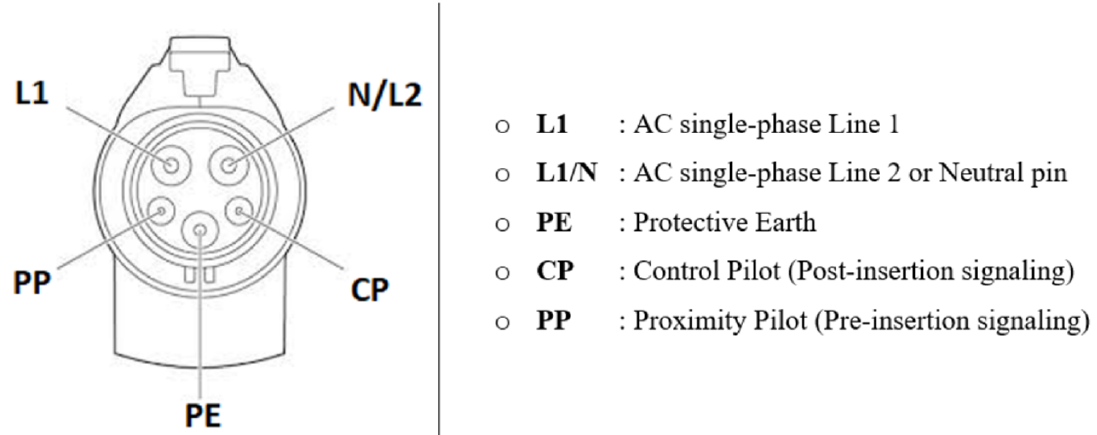
Figure 12. Pinout of the SAE J1772 Plug.